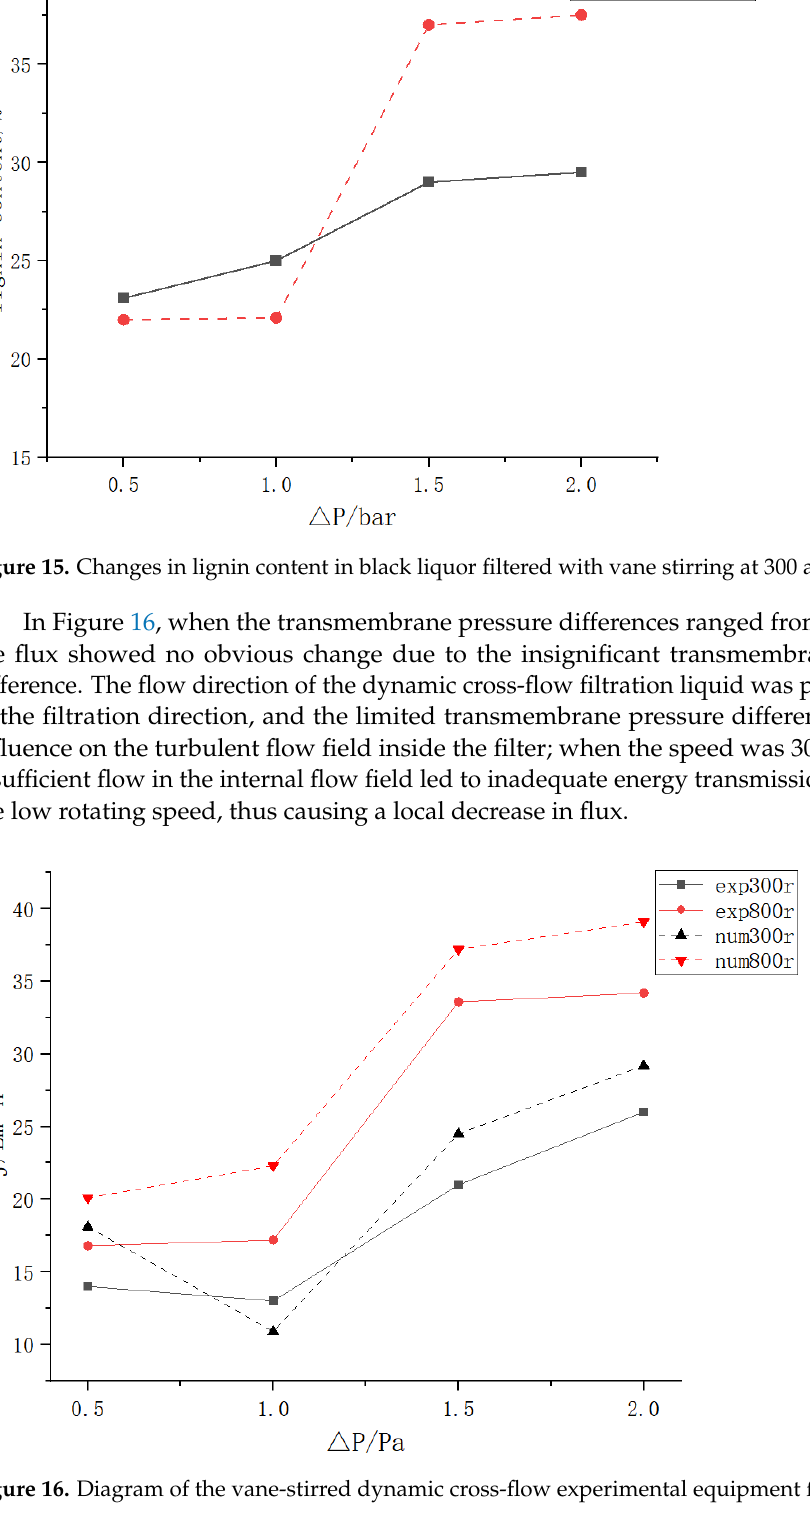
Figure 16. Diagram of the vane-stirred dynamic cross-flow experimental equipment flux.